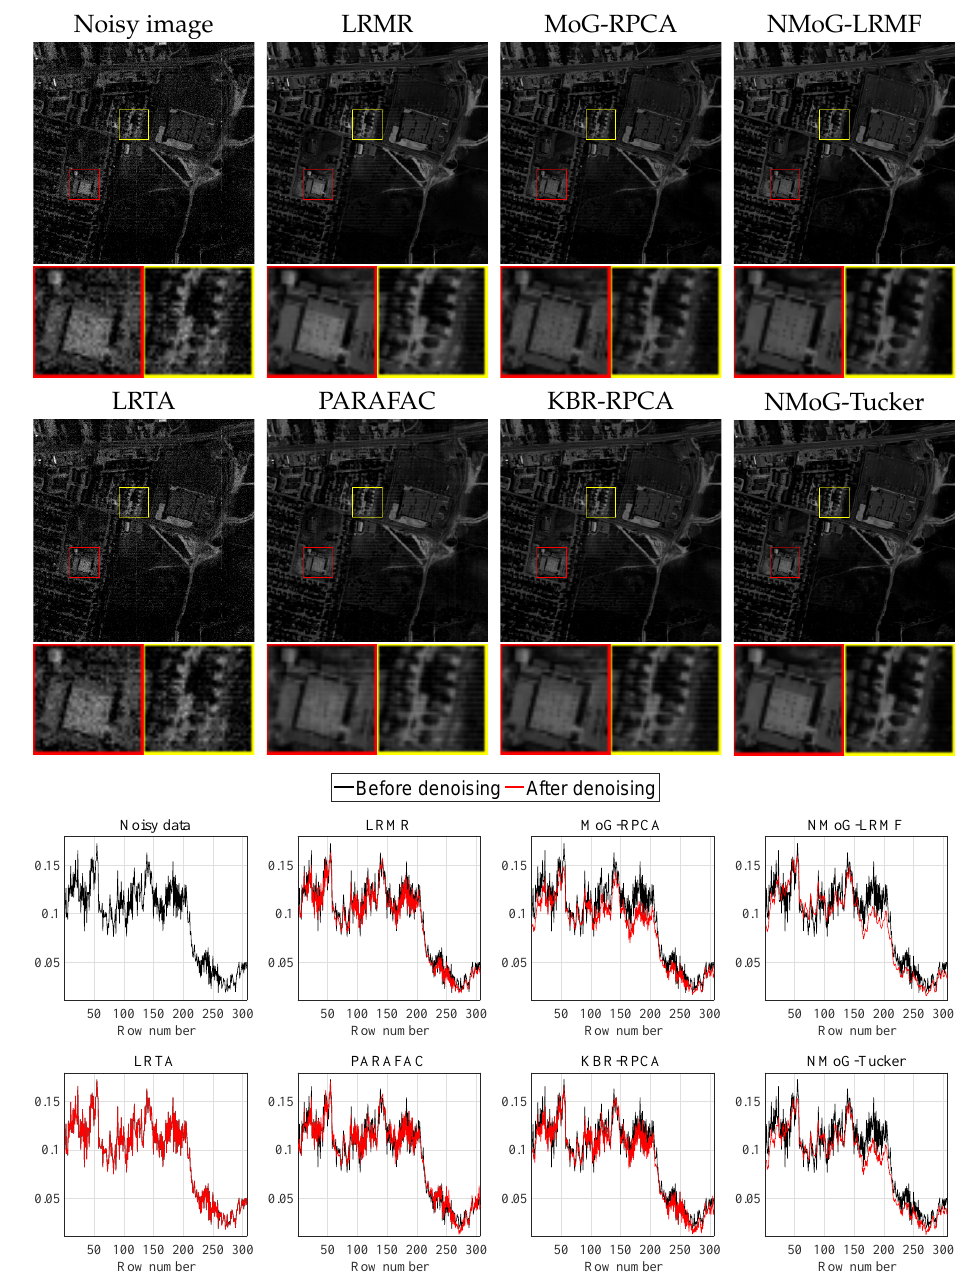
Figure 9. Real HSI denoising example on band 206 in Urban under severe noise. Top two rows: the noisy image and the denoising results by different methods, where show enlargements of two demarcated patches for better visualization. Bottom two rows: the corresponding horizontal mean